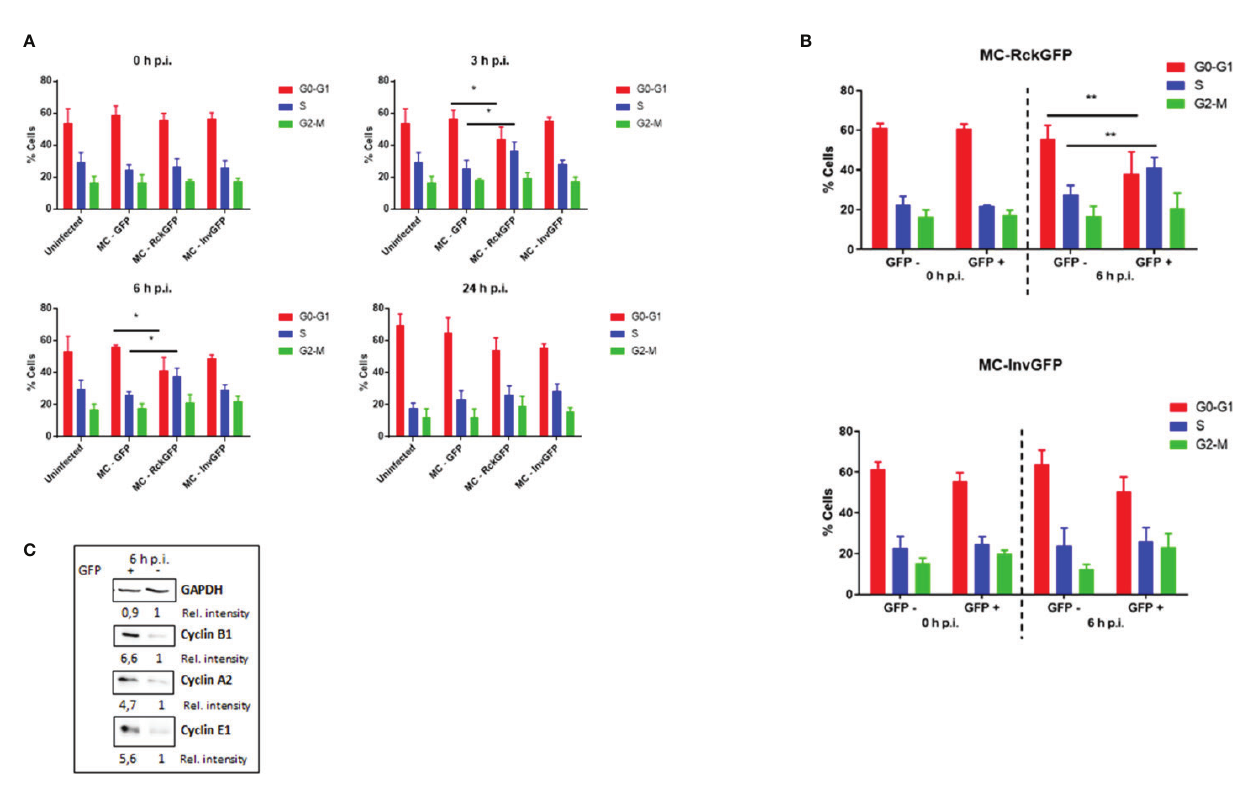
FIGURE 2 | Rck-mediated infection alters the host cell cycle phase distribution. HCT116 cells were infected with MC-RckGFP, MC-InvGFP or MC-GFP strain for 1 h at a MOI of 100. At the indicated times, cell cycle distribution was analyzed (A) before or (B) after cell sorting [cells with internalized bacteria (GFP+) and cells without internalized bacteria (GFP − )]. Results are means ± SD of the percentage of cells in the different phases of the cell cycle. Data were compared using a Mann-Whitney test (*: p < 0.05; **: p < 0.01; MC-GFP vs. MC-RckGFP for total cells and GFP − vs. GFP+ for sorted cells). At least three independent experiments were performed. (C) Cyclin B1, A2 and E1 expression was examined in GFP − and GFP+ cells after sorting at 6 h p.i. and with GAPDH as a protein loading control. This Figure shows an immunoblotting analysis from one experiment, representative of three. Rel. intensity , relative